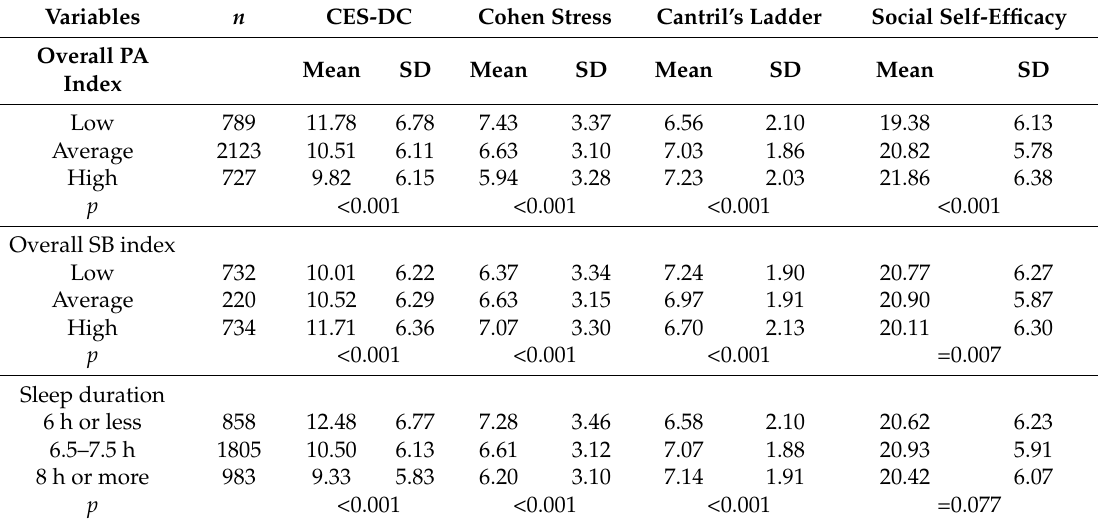
Table 3. Mental well-being of adolescents according to selected behavioural